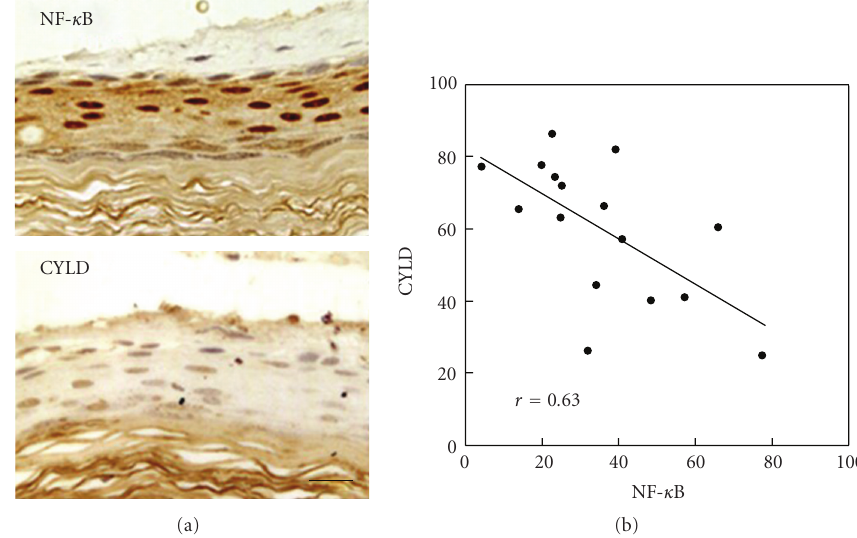
Figure 3: Analysis of the correlation between CYLD and activated NF- κ B in cholesteatoma. (a) The calculations were based on the immunohistochemical results of the expression rate of cells positive for CYLD and nuclear NF- κ B in the serial section. (b) The graph shows the correlation between CYLD and activated NF- κ B in cholesteatoma. The data indicated a significant inverse correlation between CYLD and activated NF- κ B expression (Pearson’s correlation test; r = − 0.630, P =